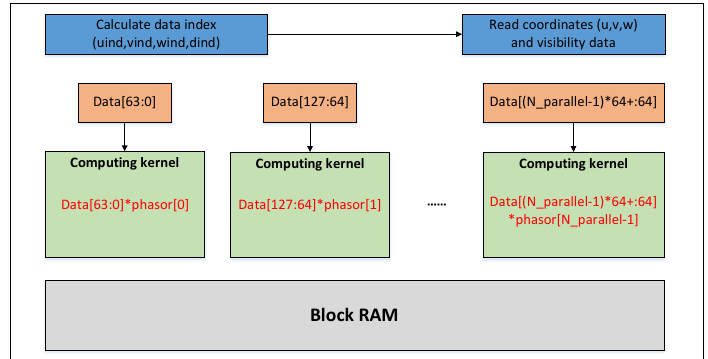
Figure 3. Parallel process flow of phase rotation algorithm.